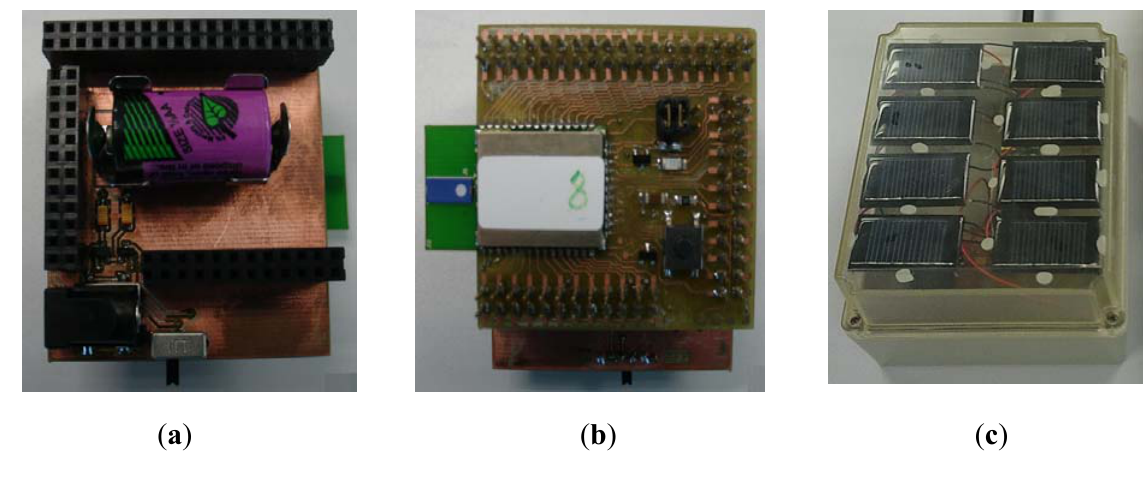
Figure 2. Bioacoustic sensor node prototype ( a ) upper side view, ( b ) down side view, and ( c ) solar-based power